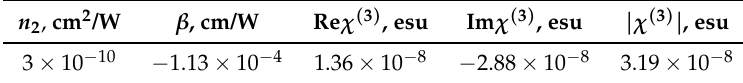
Table 2. Nonlinear optical characteristics of polymer layer with Ag